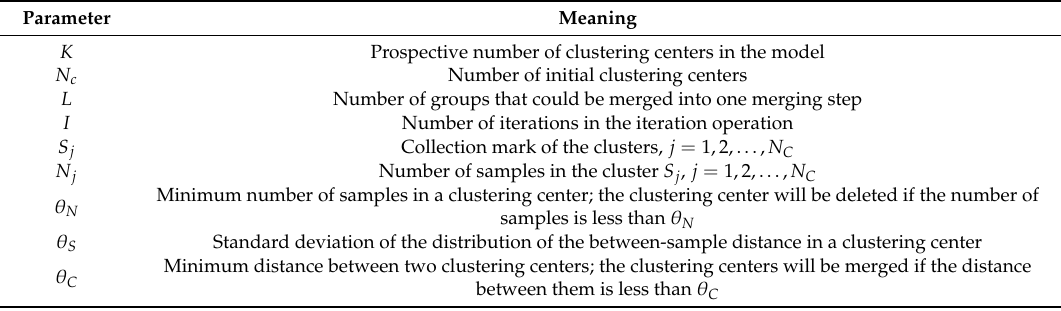
Table 1. The parameters of the proposed Origin-Destination (O-D) hotspot clustering model.